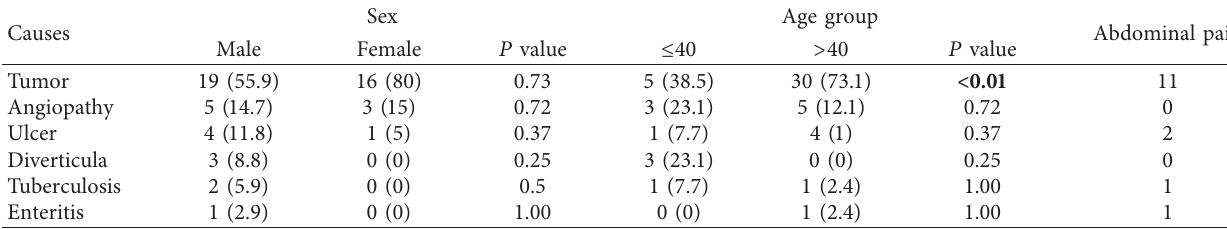
Table 2: Causes and associated factors of small bowel bleeding.